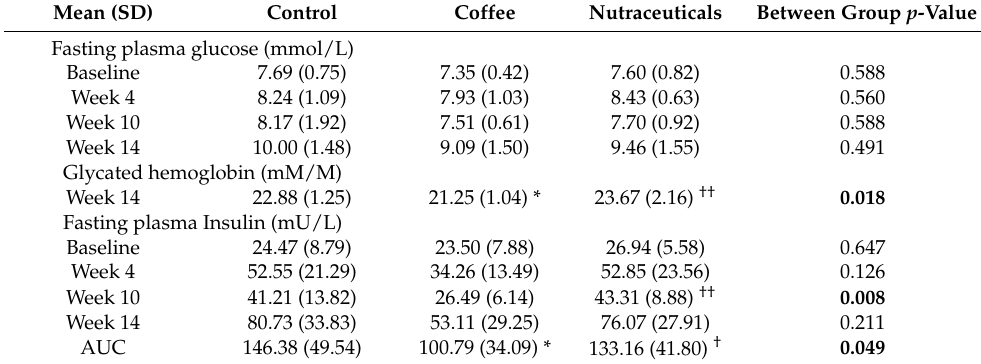
Table 1. Mean (SD) of glucose and insulin measures recorded four times during the intervention period; AUC: area under the curve of repeated measurements. Significant one-way ANOVA p -values are in